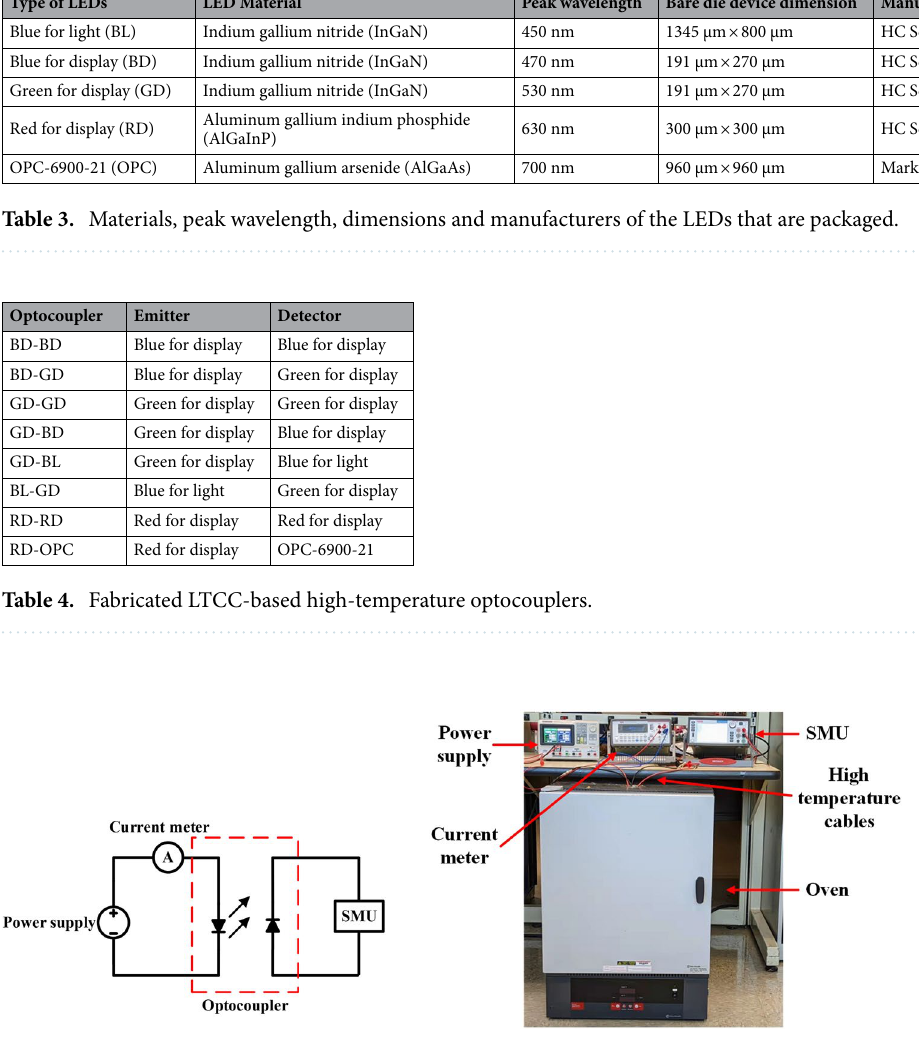
Figure 3. ( a ) Schematic and ( b ) experimental setup for DC